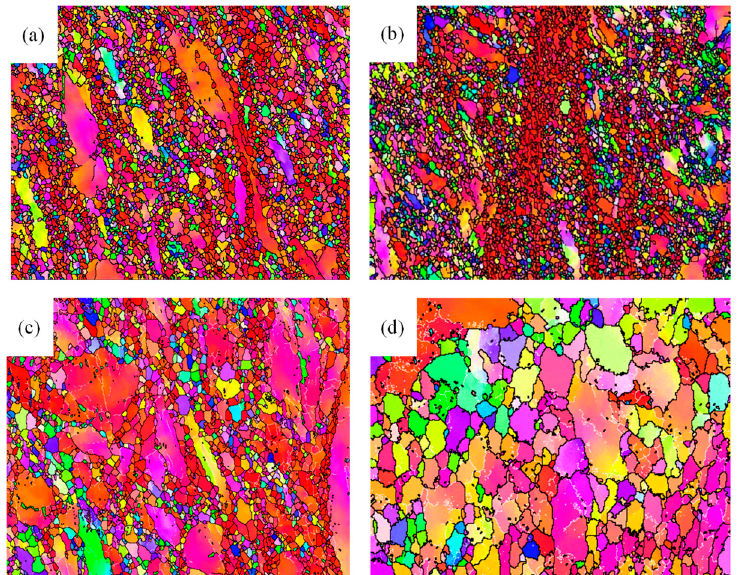
Figure 5. Microstructure of magnesium under different routes [45]: ( a ) A route; ( b ) C route; ( c ) B C route after 1 pass; ( d ) B C route after four passes. Reproduced with permission from MDPI.